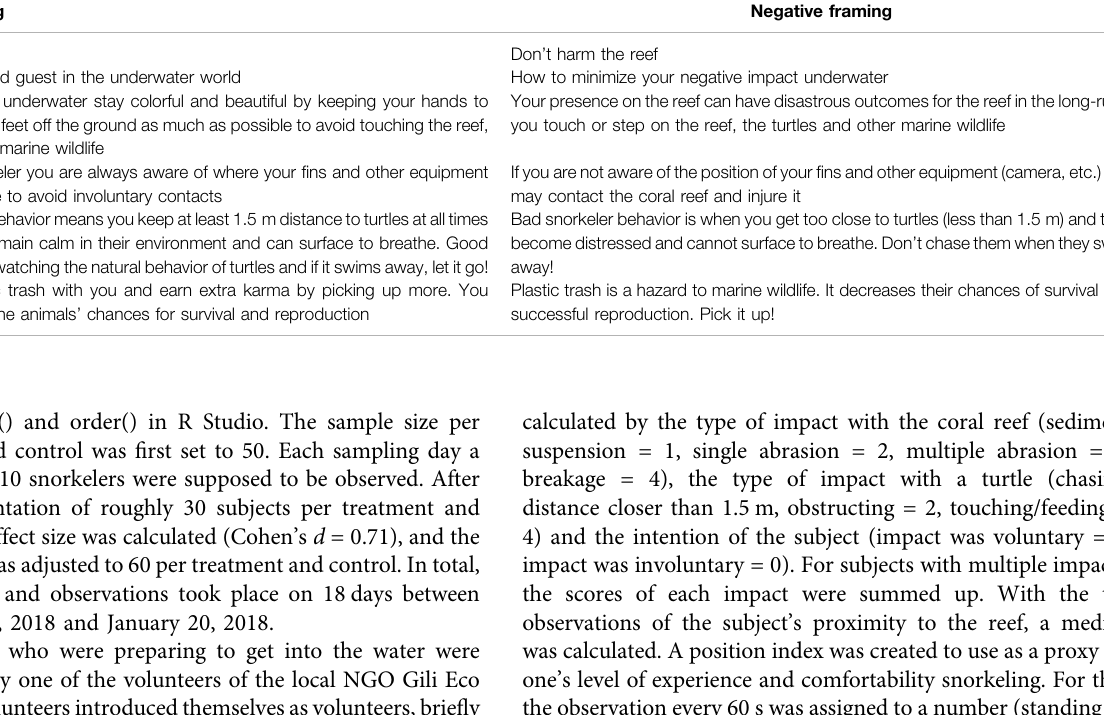
TABLE 6 | Brie fi ng sheets with four key notes highlighting positive (careful) snorkeling behavior (left) and negative (damaging) snorkeling behavior (right). Positive